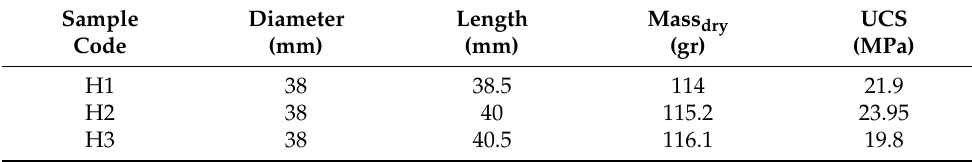
Table 2. UCS values obtained for High-porosity sandstone samples.